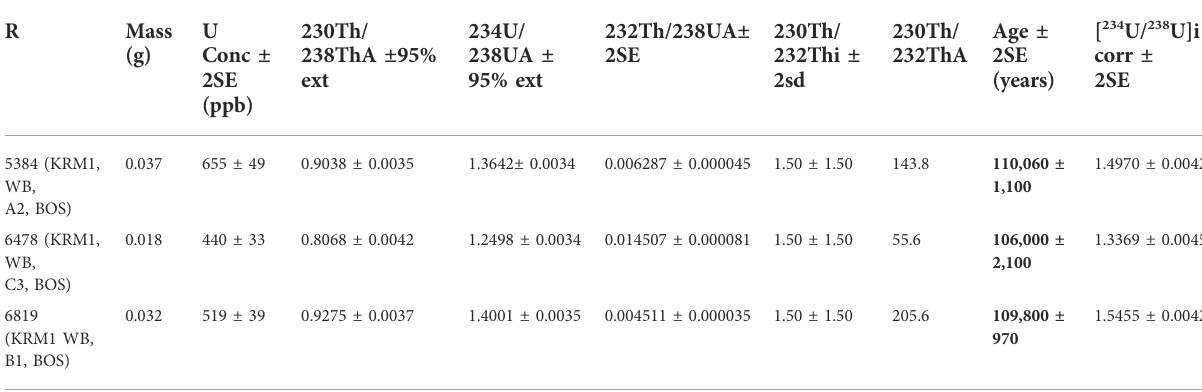
TABLE 2 U-series